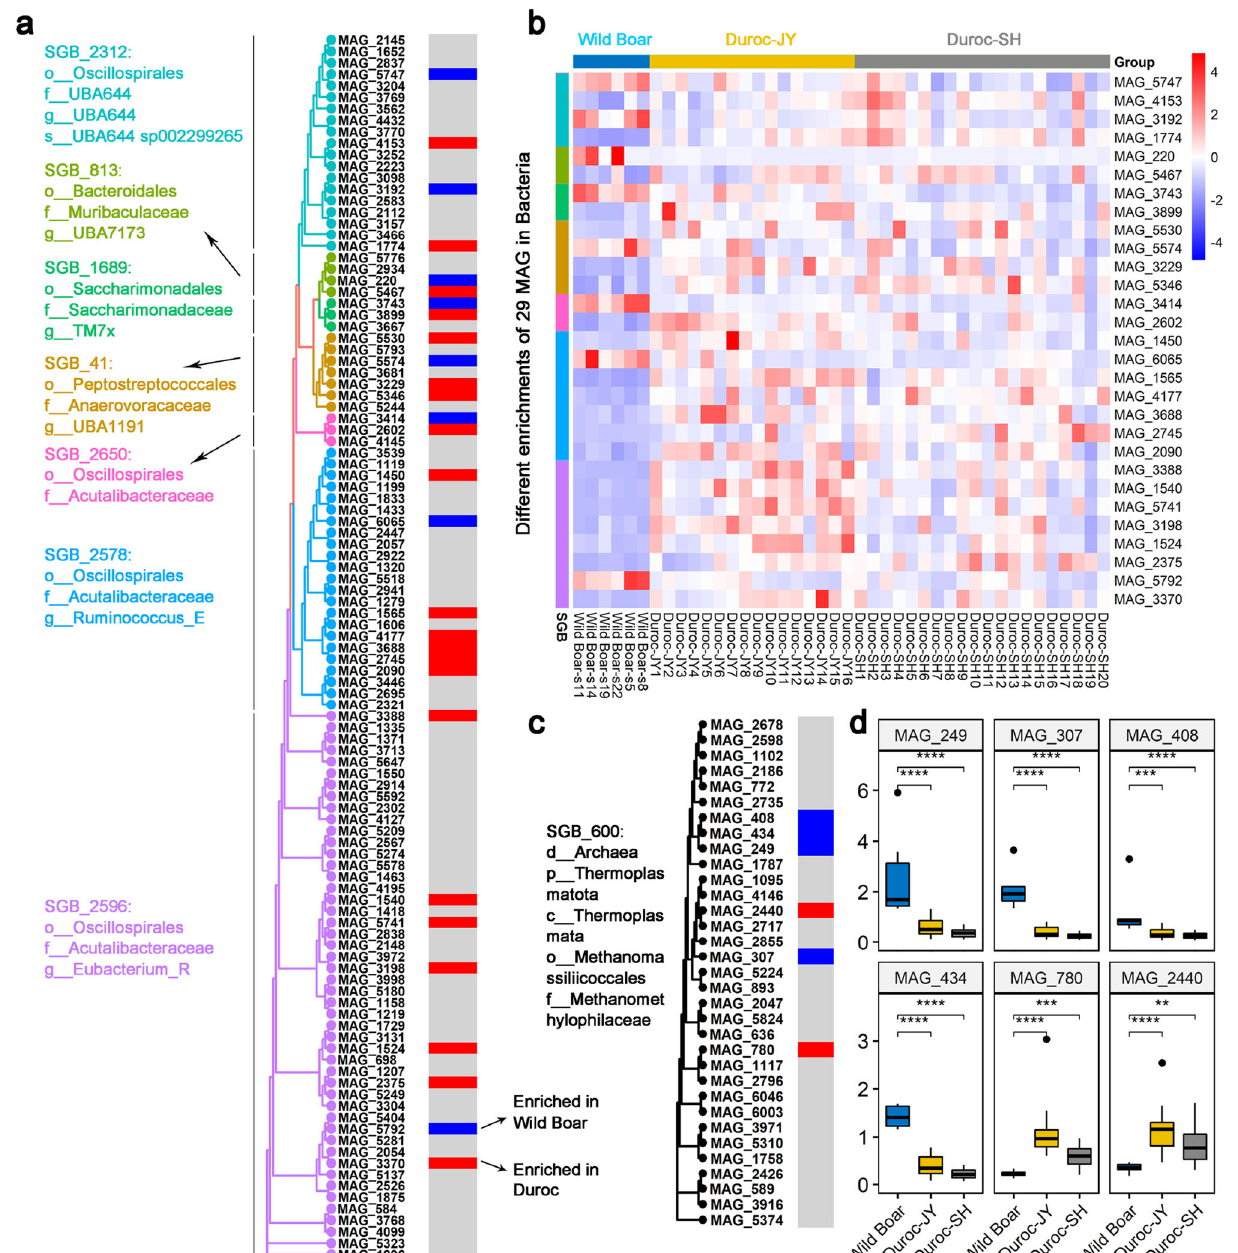
Fig. 6 The species-level genome bins (SGBs) containing metagenome-assembled genomes (MAGs) showing different directions of enrichment in wild boars and Duroc pigs. a The phylogenetic tree showing all MAGs from seven SGBs belonging to bacteria. The different colors distinguish each SGB. In each of these seven SGBs, some MAGs were enriched in wild boars (blue bars), some MAGs in Duroc pigs (red bars), and the others did not show signi fi cant difference between wild boars and Duroc pigs (gray). b Heatmap showing the different enrichments of the 29 MAGs from seven SGBs described above between wild boars and Duroc pigs. c The phylogenetic tree showing all MAGs from SGB_600, which belongs to Methanomethylophilaceae in Archaea. Four MAGs in this SGB were enriched in wild boars (blue bars) and two MAGs enriched in Duroc pigs (red bars). d Boxplots showing the different abundances of the six MAGs in the SGB_600 between wild boars ( n = 6) and Duroc pigs (Duroc-JY: n = 16, Duroc-SH: n = 20). * P < 0.05, ** P < 0.01, *** P < 0.001, **** P < 0.0001, two-tailed Wilcoxon test was used Boxplots show median, 25th and 75th percentile, the whiskers indicate the minima and maxima, and the points laying outside the whiskers of boxplots represent the